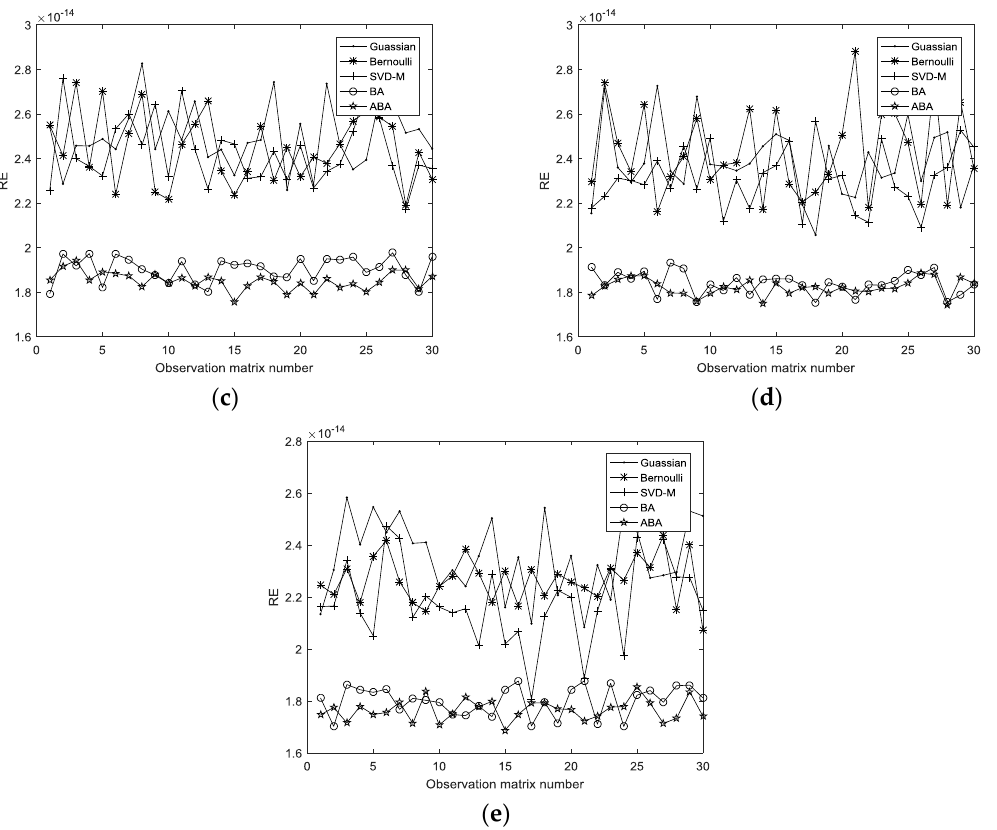
Figure 7. Reconstruction error of each algorithm to signal-4 with different compression ratio: ( a ) Rate = 0.3; ( b ) Rate = 0.35; ( c ) Rate = 0.4; ( d ) Rate = 0.45; ( e ) Rate = 0.5.